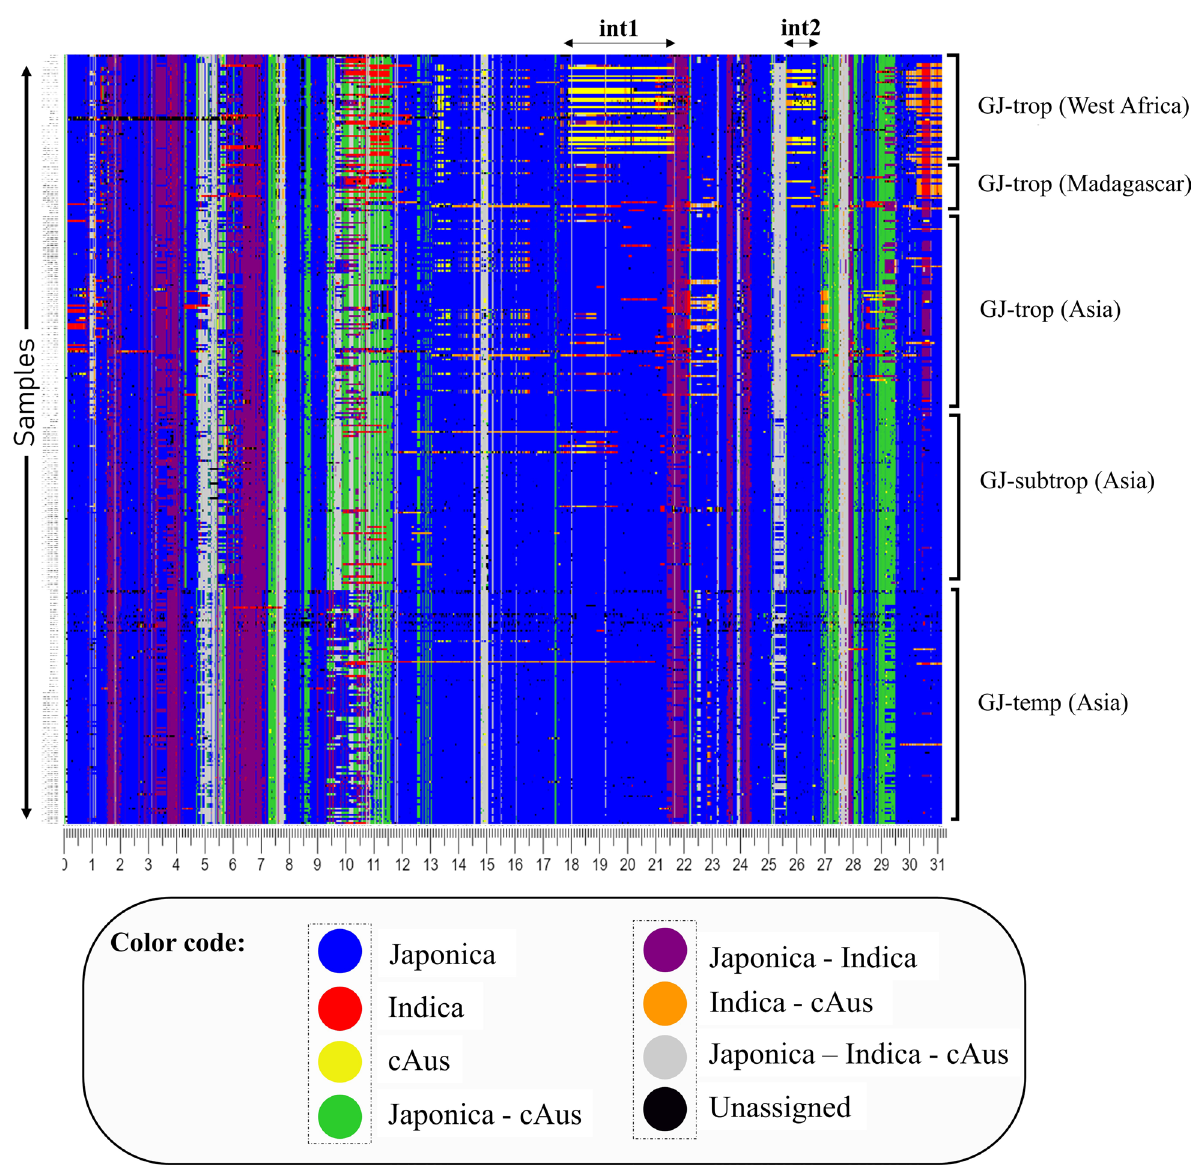
Fig. 3 Local haplotype assignment on chromosome 6 of japonica varieties: Accessions are arranged from top to bottom by geographical subgroups. The base colours are defined according to whether a haplotype window has been assigned to one of these references: japonica (blue), indica (red) and cAus (yellow). However, when the haplotype is shared between two source populations, it is then coloured with the combined colors of its two main components: japonica-indica (purple), japonica-aus (green) and aus-indica (orange). When a haplotype is not group-specific, it is coloured grey. Finally, when the SNPs composing the haplotype window are absent from the source populations, it is shaded in